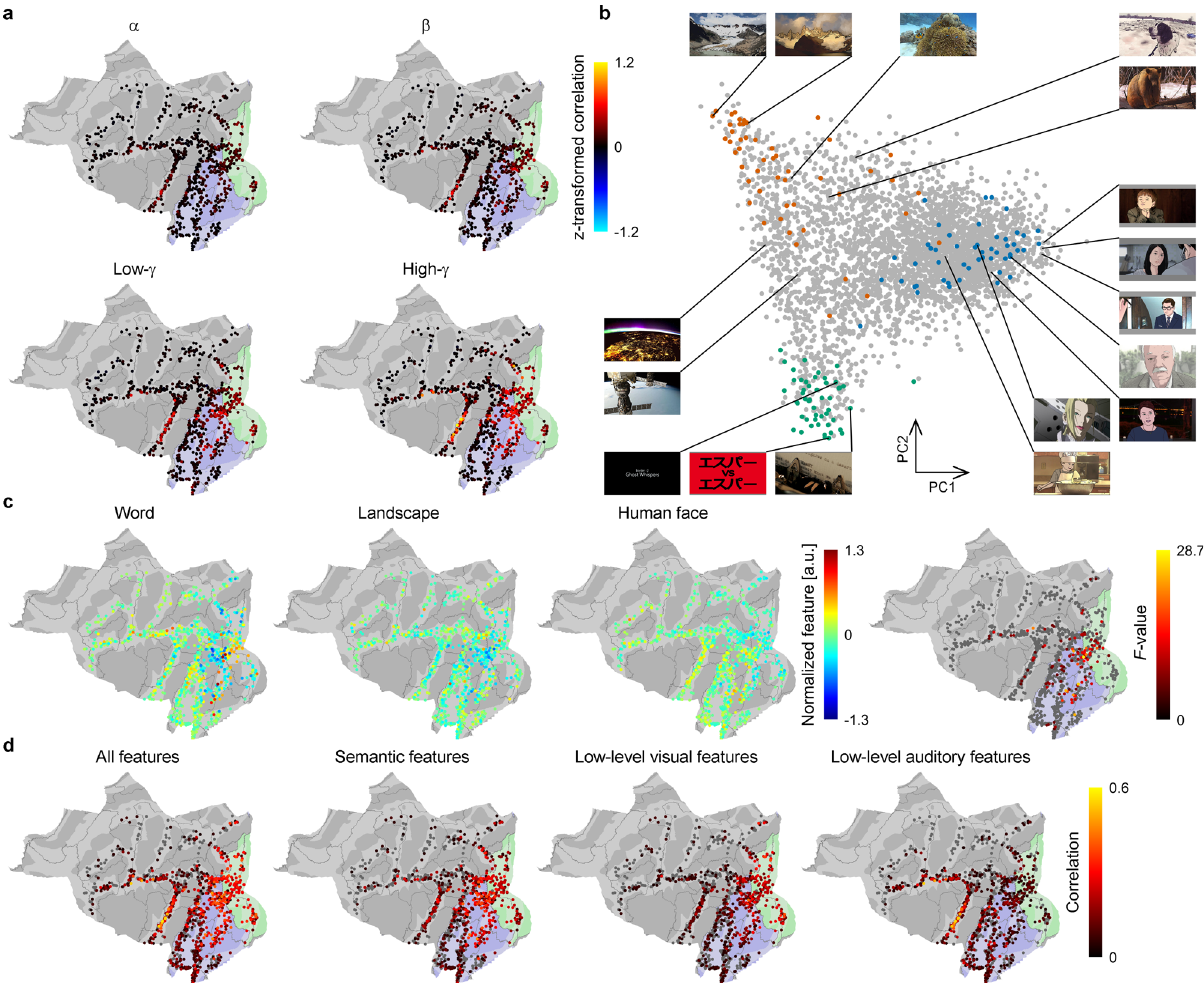
Fig. 2 Visual semantic space and high- γ powers/features in the video-watching task. a The Fisher z-transformed Pearson ’ s correlation coef fi cients between the 150 powers corresponding to repeated 2.5-min movies in the validation video were averaged across all possible combinations of the repetitions to be color-coded on each electrode. Areas shaded with blue and green denote the higher and early visual areas, respectively. b Each scene in the training videos is shown at a position based on the fi rst and second principal components (PCs) of the semantic vectors. Green, red, and blue points represent the positions of 50 scenes selected as representative of the categories of “ word ” , “ landscape ” , and “ human face ” , respectively. c In the training videos, the high- γ features corresponding to the 50 selected scenes from the three categories were averaged within each category and were color-coded at the location of the electrodes. For visibility, features of each electrode were z -scored within 3600 scenes. The F -values of ANOVA for the high- γ features were similarly color-coded at each electrode ( P < 0.05, n = 50 for each group, one-way ANOVA, adjusted using the Benjamini – Hochberg procedure). d Pearson ’ s correlation coef fi cients between the high- γ features while subjects watched the training videos and the inferred high- γ features were color- coded and shown at the location of the electrode. For each outer fold of the tenfold nested cross-validation, a decoder (ridge regression model) was fi rst trained to infer high- γ features using all features (semantic features, and the low-level visual and auditory features) from the videos; then, for each feature set, the weights corresponding to the other two feature sets were set to zero before the regression model was applied to the test data. A correlation map of each feature set was calculated from the entire 3600 scenes. Only electrodes that showed signi fi cant positive correlations are shown ( P < 0.05, n = 3600 for each electrode, one-sided Pearson ’ s correlation test, adjusted using the Benjamini – Hochberg procedure for each The classi fi cation was considered to be correct when the ; v i Þ was the highest for the category of the R ð v category inferred presented scene. The accuracies to classify two of the three categories (binary accuracies) were 67.5 ± 4.7% (mean ± 95% con fi dence intervals [CIs] among subjects) for word versus landscape, 70.8 ± 4.8% for landscape versus human face, and 73.1 ± 4.5% for human face versus word, all of which were signi fi cantly higher than chance level (50%) ( P < 1.0 × 10 − 6 , n = 17, one-sided one-sample t -test with Bonferroni-adjusted α -level